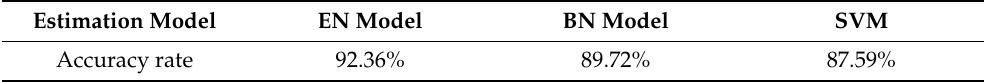
Table 5. Comparison of target intention recognition accuracy.